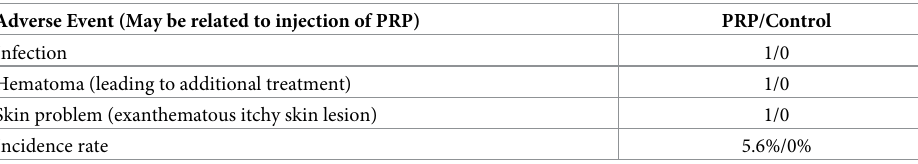
Table 2. Adverse event reported in the Flury’s study. Adverse Event (May be related to injection of